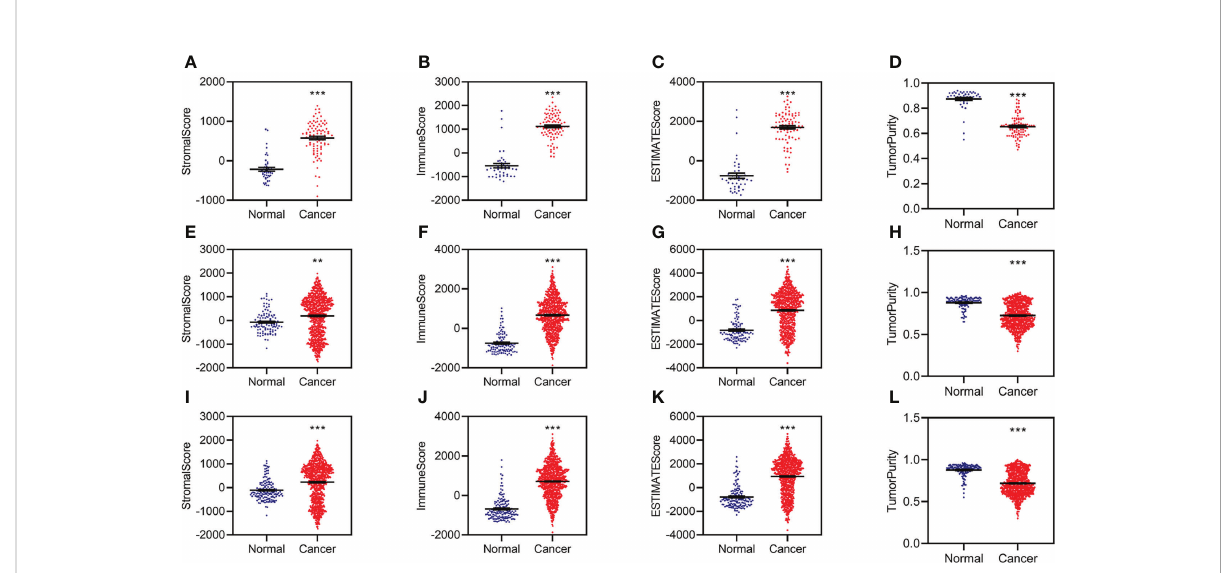
FIGURE 1 Aberrant stromal and immune status for KC. (A – D) Difference analysis of stromal score (A) , immune score (B) , ESTIMATE score (C) , and tumor purity (D) between normal and KC patients in the training group. (E – H) Difference analysis of stromal score (E) , immune score (F) , ESTIMATE score (G) , and tumor purity (H) between normal and KC patients in the validation group. (I – L) Difference analysis of stromal score (I) , immune score (J) , ESTIMATE score (K) , and tumor purity (L) between normal and KC patients in the entire group. **p < 0.01, ***p <